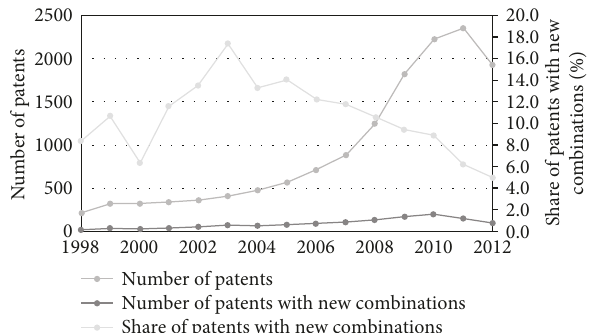
Figure 3: The process of registering photovoltaic technology patents [32].